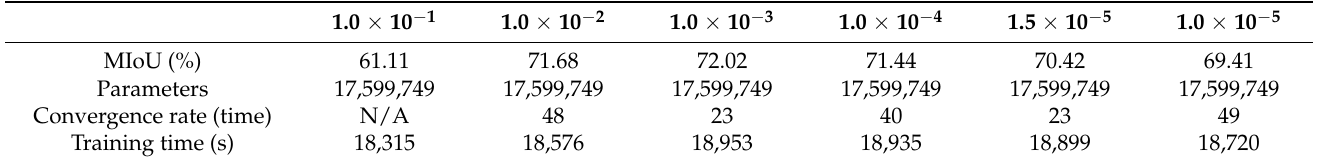
Table 6. Model training results under different learning rate